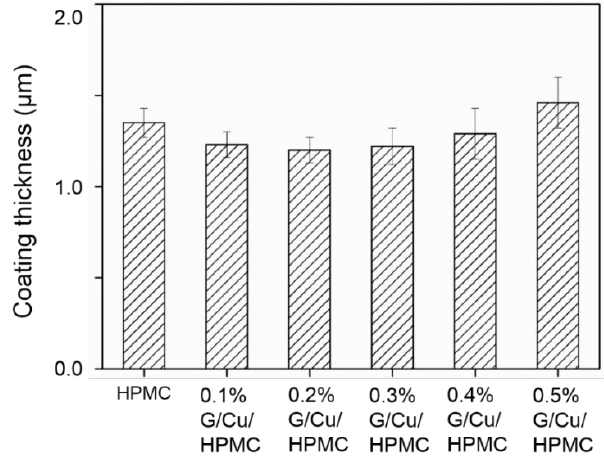
Figure 3. Thickness of composite coating with different amounts of nano-graphene/copper additive.